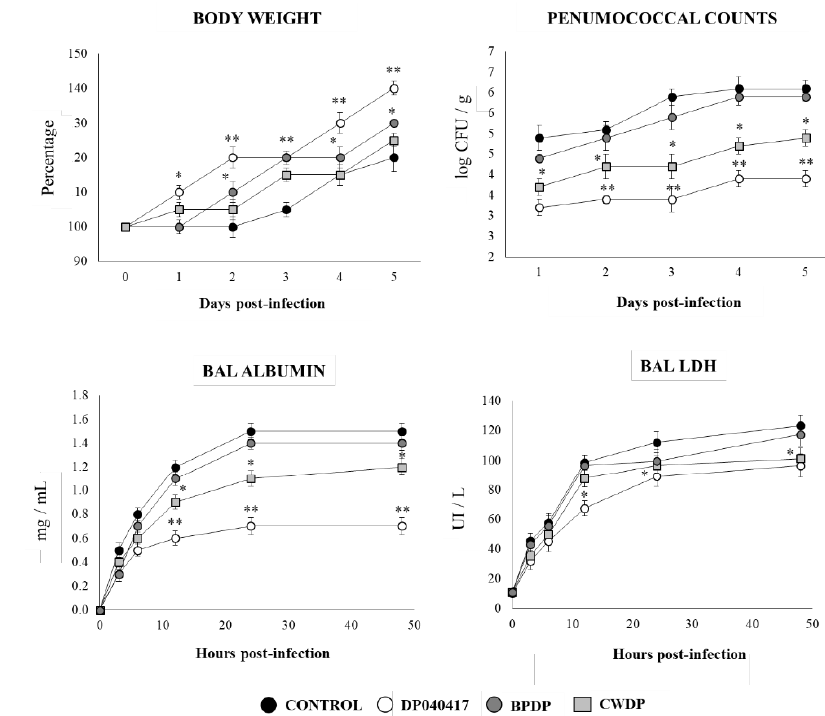
Figure 11. Effect of Dolosigranulum pigrum 040417 on the resistance to Streptococcus pneumoniae infection. Infant mice were nasally primed with viable (DP), bacterium-like particles (BPDP) or cell wall (CWDP) from D. pigrum 040417 during five consecutive days and then challenged with pneumococci. Non-treated infant mice challenged with the bacterial pathogen were used as controls. Lung pneumococcal cell counts, changes in body weight, and lactate dehydrogenase (LDH) activity and albumin concentrations in broncho-alveolar lavages (BAL) were evaluated on different time points after the viral challenge. Experiments were performed with 5 – 6 mice per group per each time point. The results represent data from three independent experiments. Significantly different when compared to control at the same time point * p < 0.05 or ** p < 0.01.